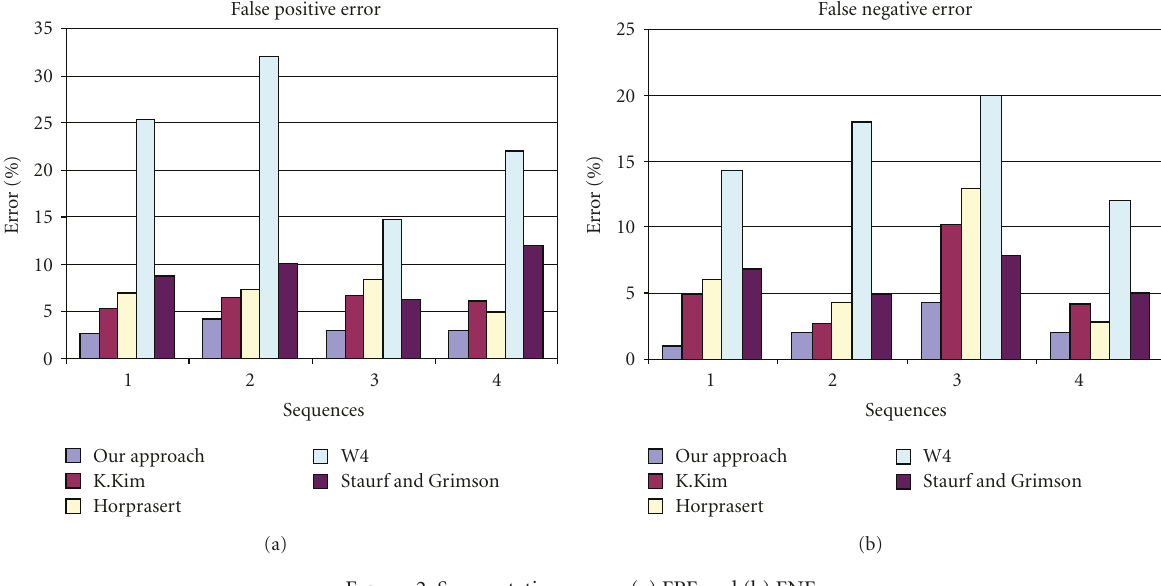
Figure 2: Segmentation errors. (a) FPE and (b)